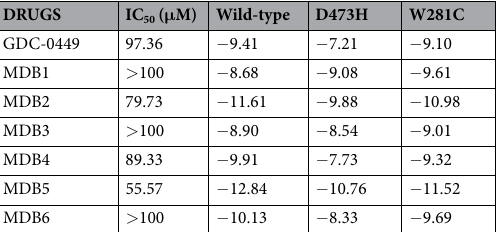
Table 1. IC 50 ( μ M) in MIA PaCa-2 cells and docking scores (kcal/mol) of respective drugs in wild-type Smo, D473H and W281C mutants of